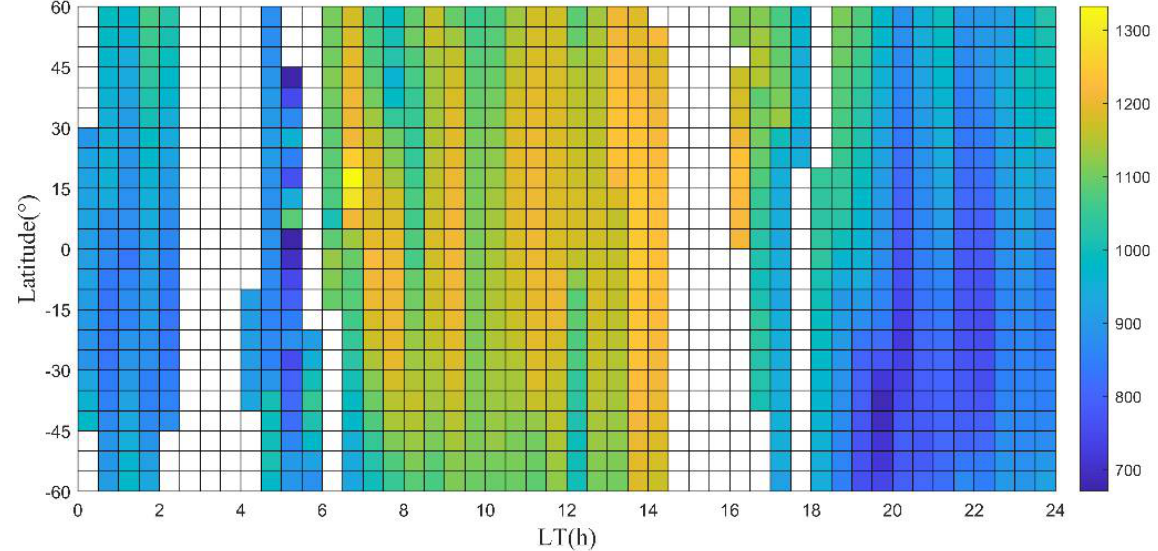
Figure 4. The diurnal variation of derived temperatures (K) from 15 April 2014 to 11 August 2014.